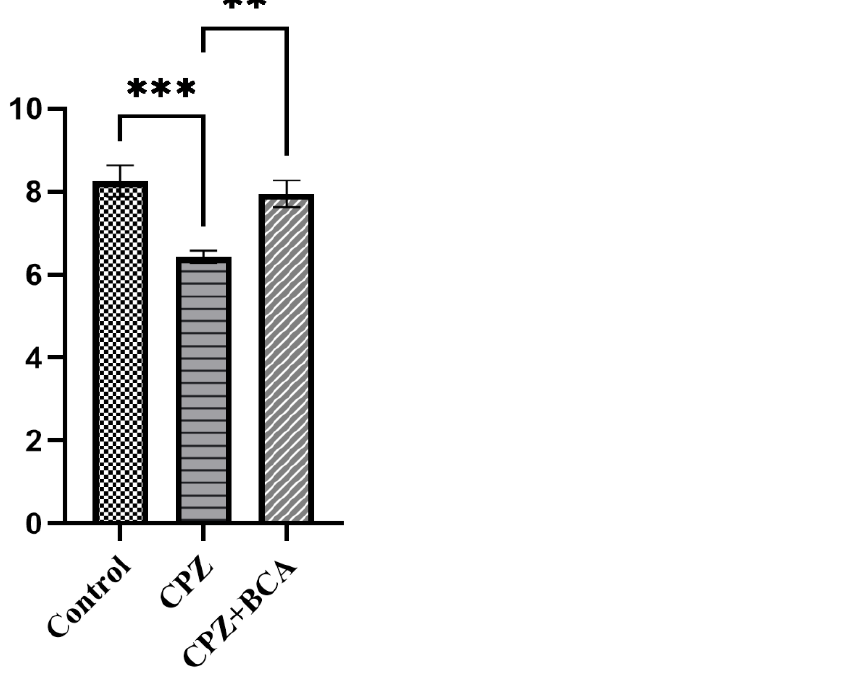
Figure 2. Grip strength test. CPZ significantly reduced the grip strength compared with the control group. BCA significantly increased the grip strength compared with the CPZ group. Data are presented as mean ± SEM. One-way ANOVA followed by Tukey’s test was used. ** p < 0.01, *** p < 0.001. (CPZ: cuprizone, BCA: biochanin A).